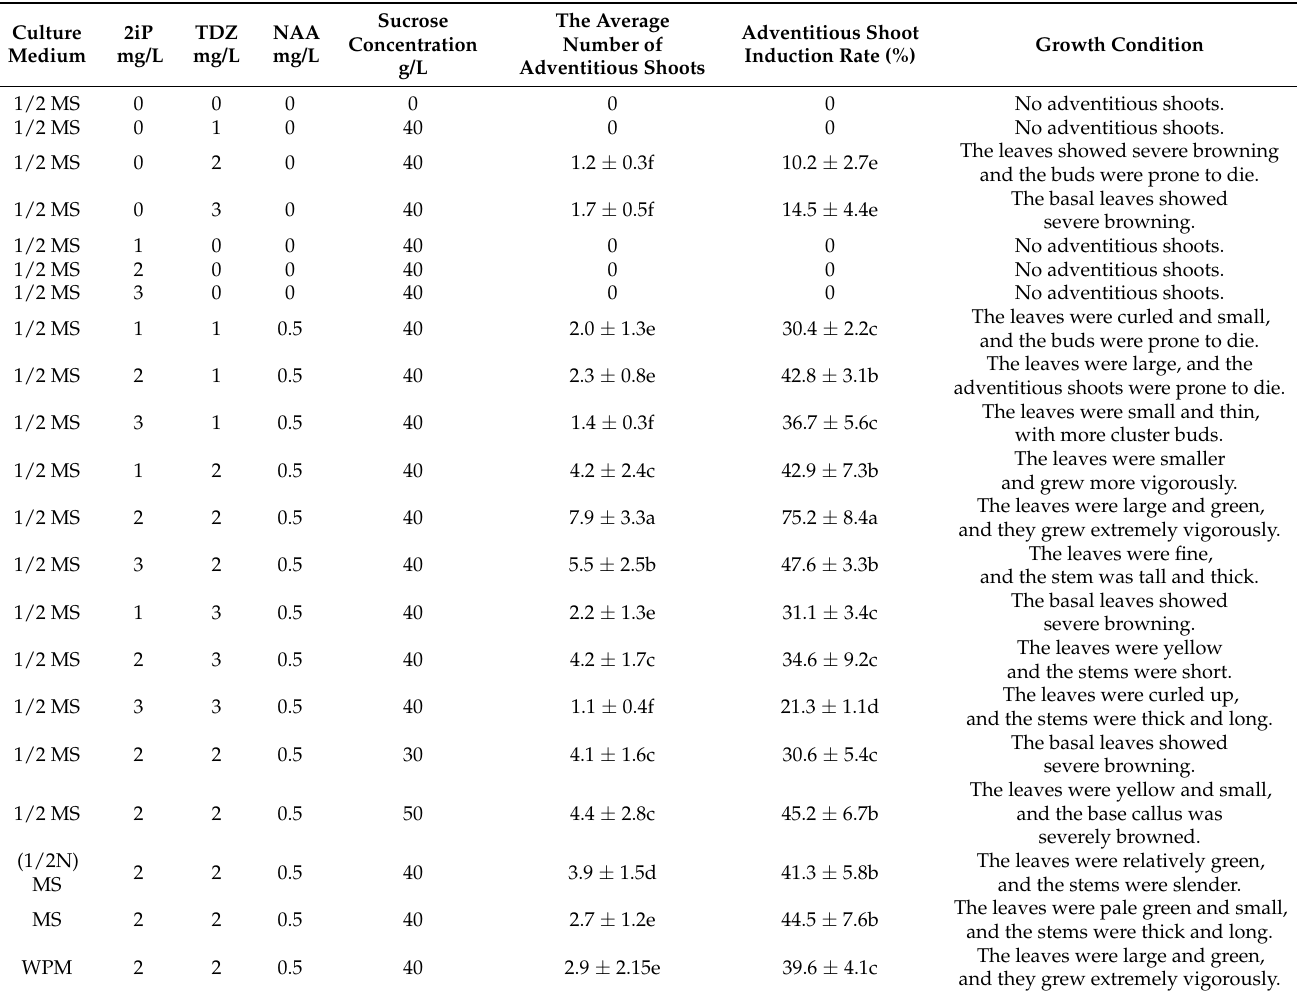
Table 4. Effects of different plant growth regulator concentrations, media, and sucrose concentration on the induction of adventitious shoots from calli of D. lotus